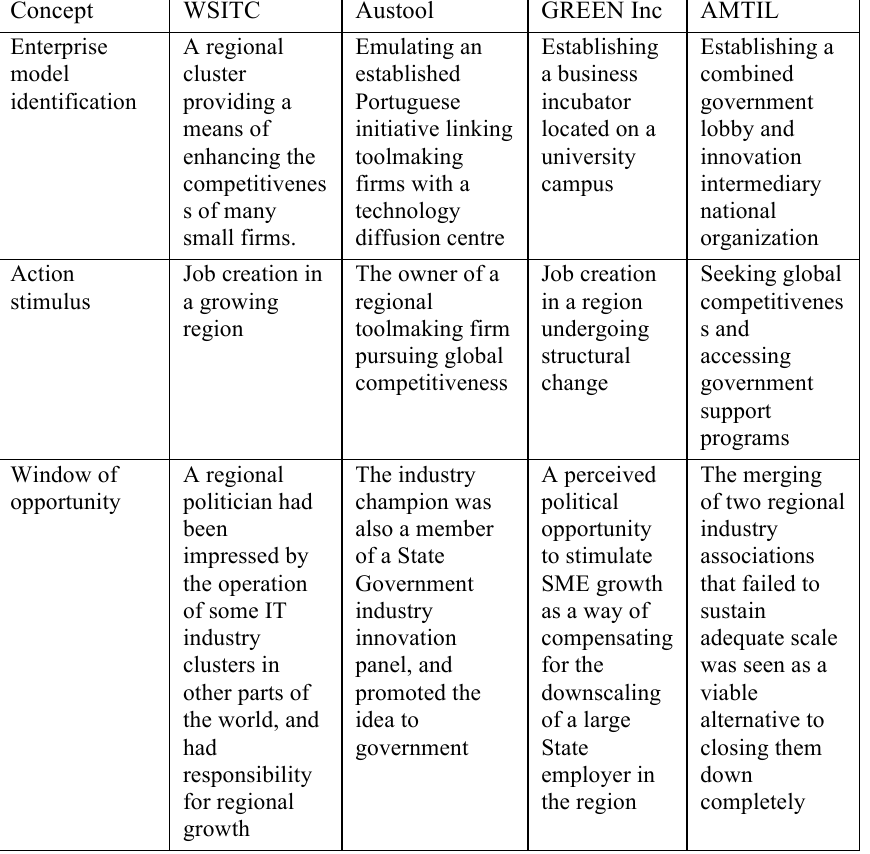
Table 4. Discovery phase